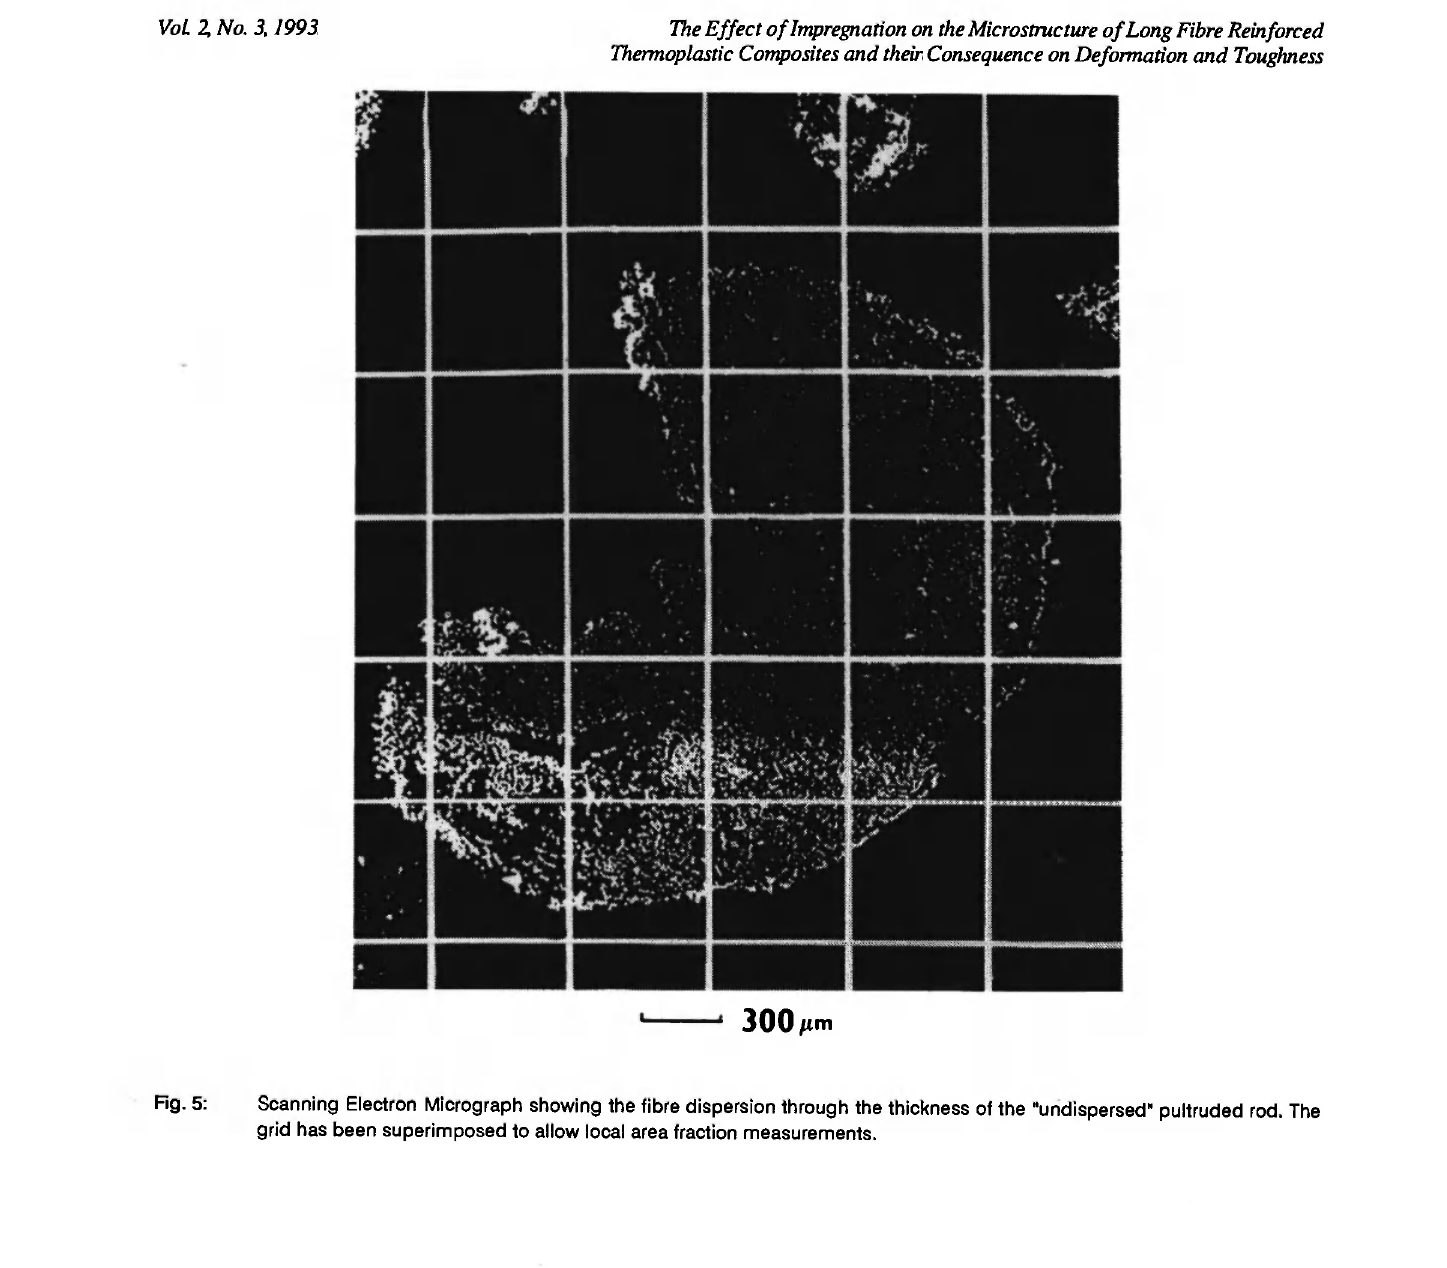
Fig. 5: Scanning Electron Micrograph showing the fibre dispersion through the thickness of the "undispersed" pultruded rod. The grid has been superimposed to allow local area fraction